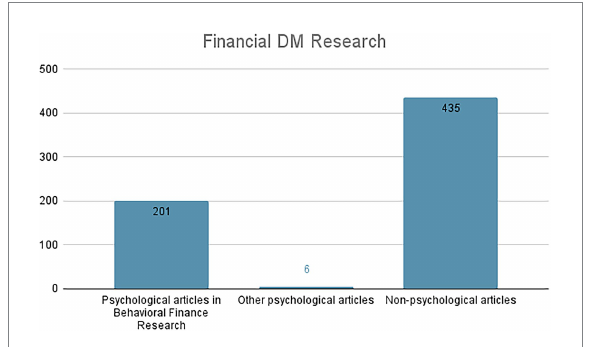
FIGURE 1 Classification of the eligible articles on FDM ( searched on Scopus on May 24 , 2022 ).